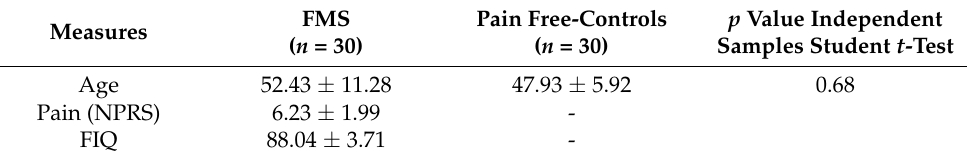
Table 1. Descriptive statistics of demographic variables (n = 60).